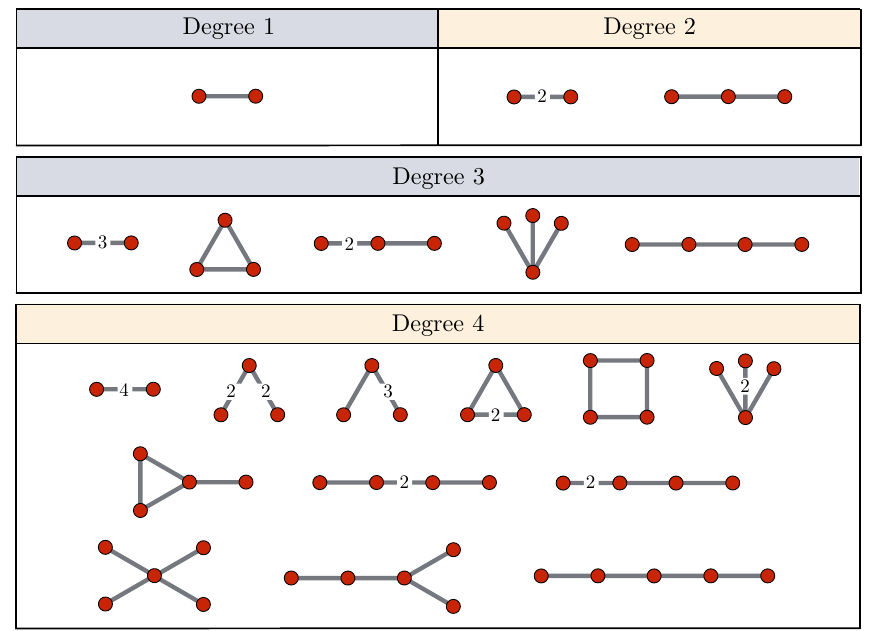
Table 2. All prime (connected) EFPs up to degree 4. For legibility, the numbers indicate the multiplicity of lines connecting the corresponding nodes. To form composite EFPs, one multiplies together these prime